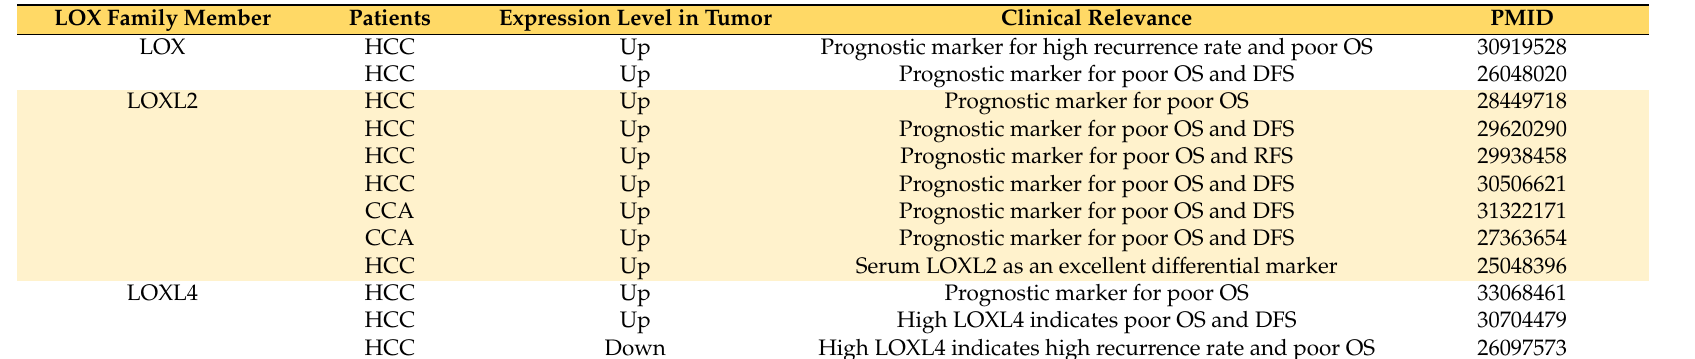
Table 1. Clinical relevance of LOX family members in liver